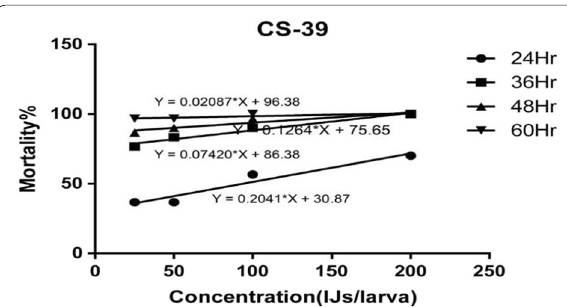
Fig. 3 Relationship between concentration of infective juveniles of Steinernema abbasi CS-39 and percent mortalities of Helicoverpa armigera at 24, 36, 48 and 60 h after